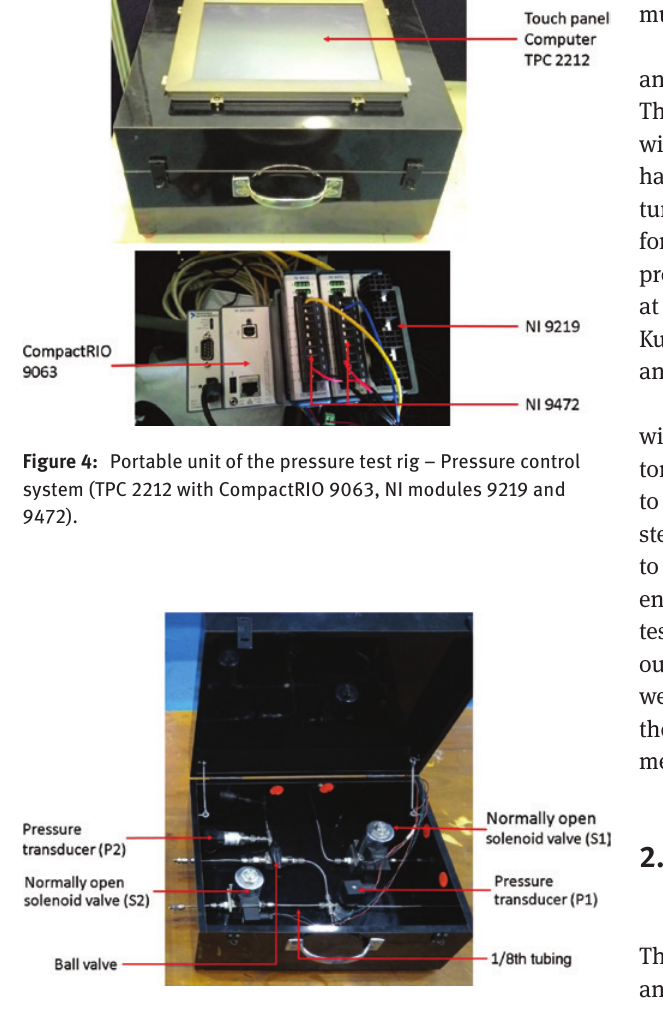
Figure 5: Portable unit of the pressure test rig – valve connections.